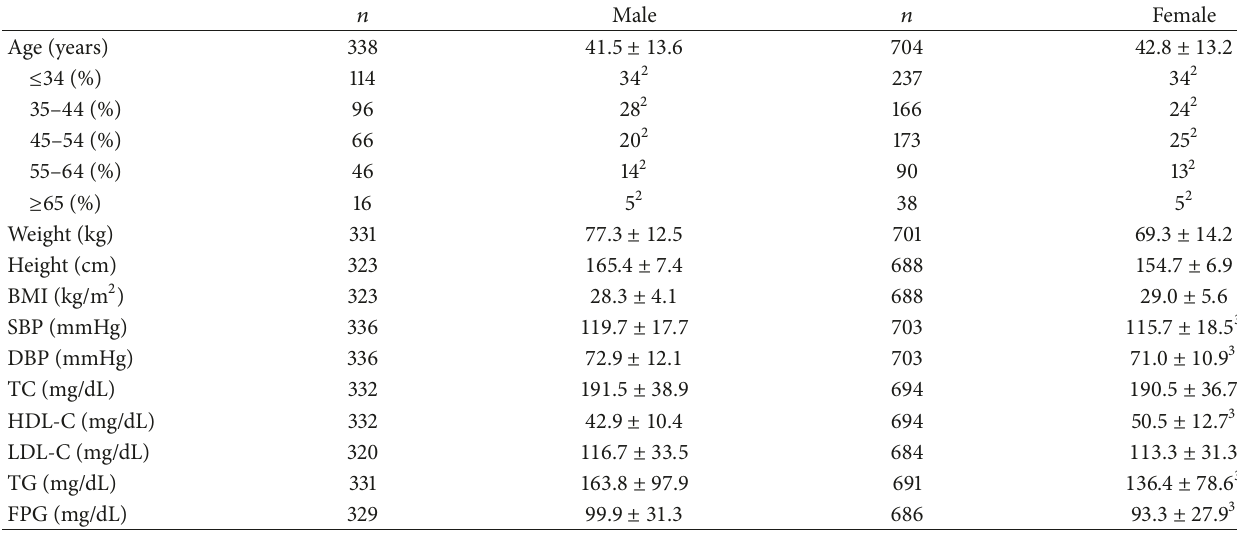
Table 1: Background characteristics of the Central and South American subjects by gender 1 .